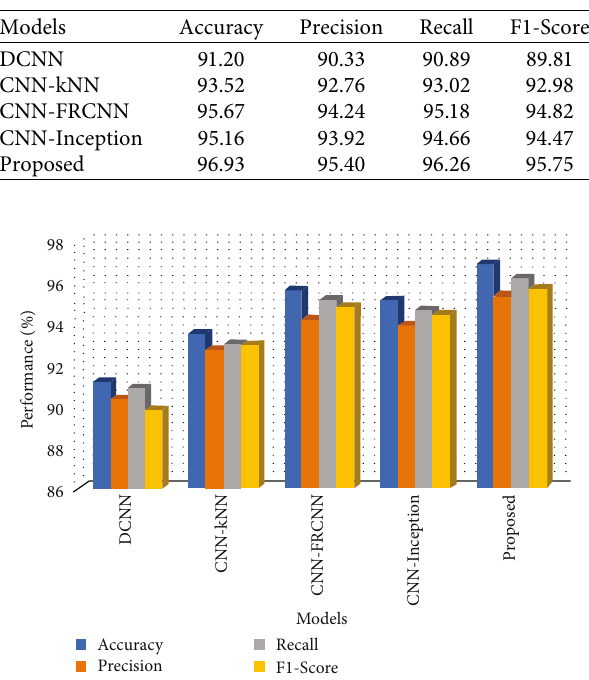
Figure 11: Graphical plot of performance analysis